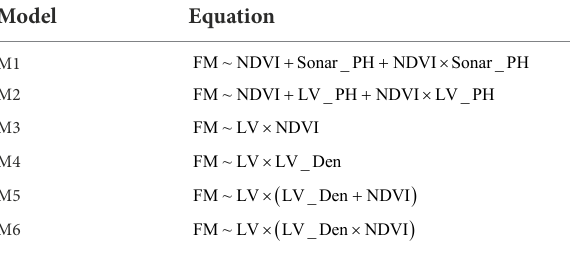
TABLE 1 Multiple linear regression models used to compare the predicted and measured fresh weight (FM) samples. Model